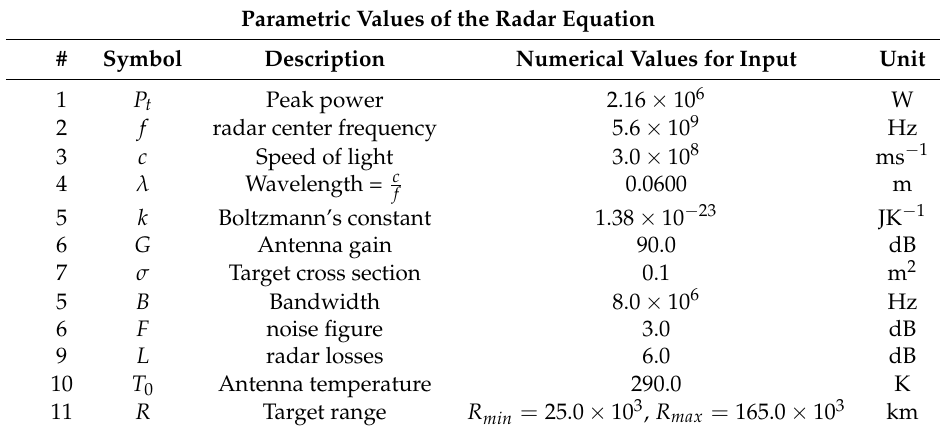
Figure 5. Matlab numerical simulation of the radar equation for different parametric values in Table 3. Table 3. Parameters of the radar